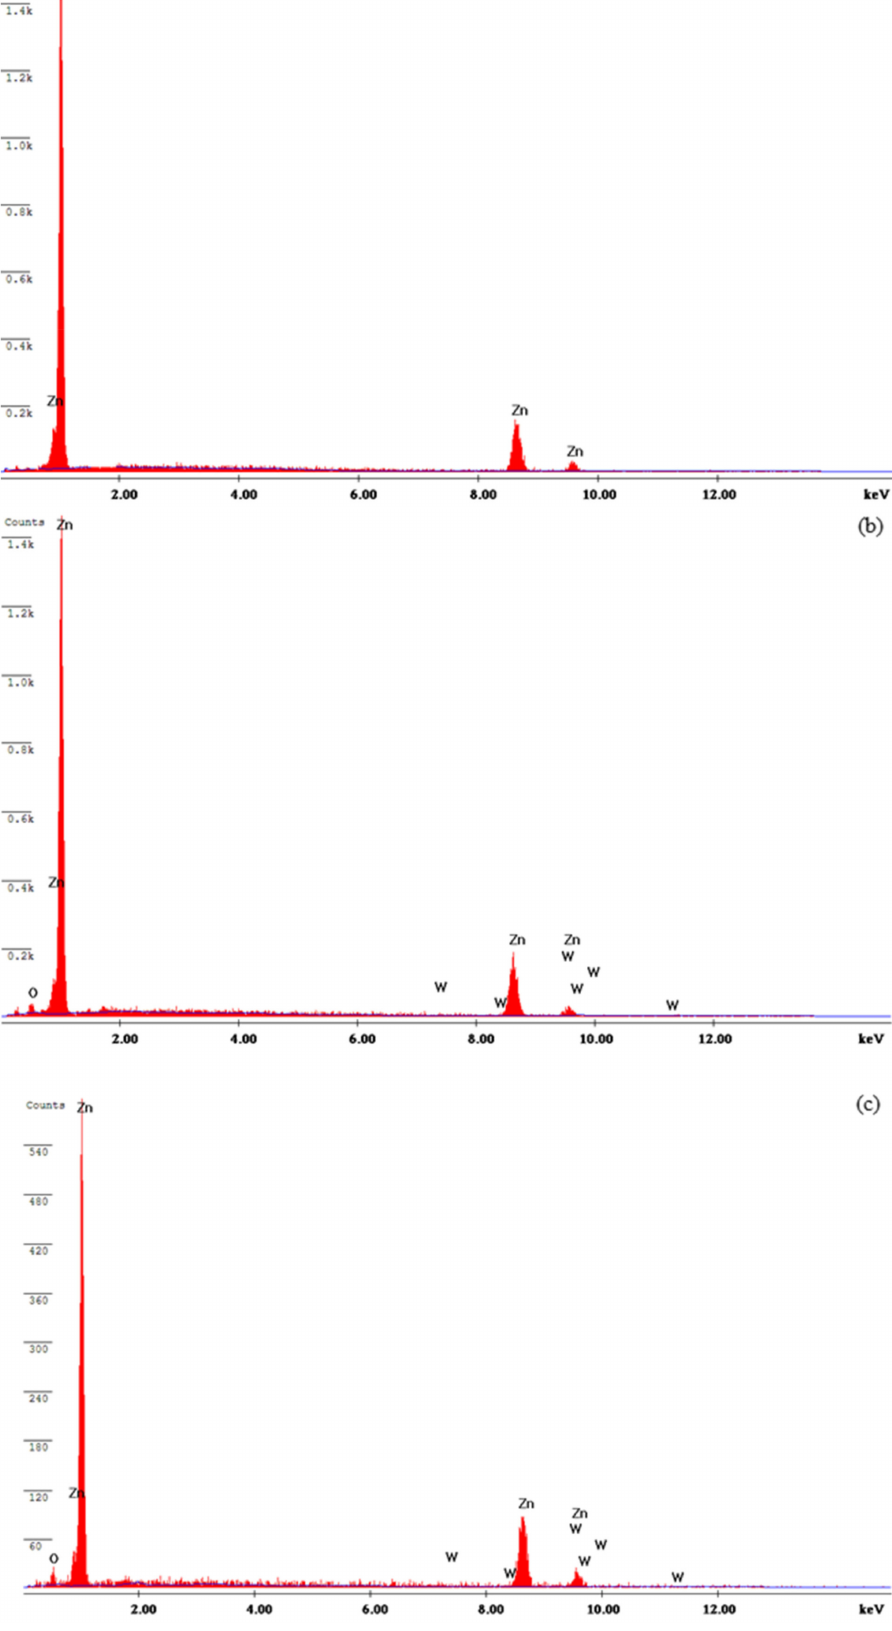
Figure 8. EDS spectra of ( a ) Zn, ( b ) Zn–WO 3 (0.5 g/L) and ( c ) Zn–WO 3 (1.0 g/L) composite